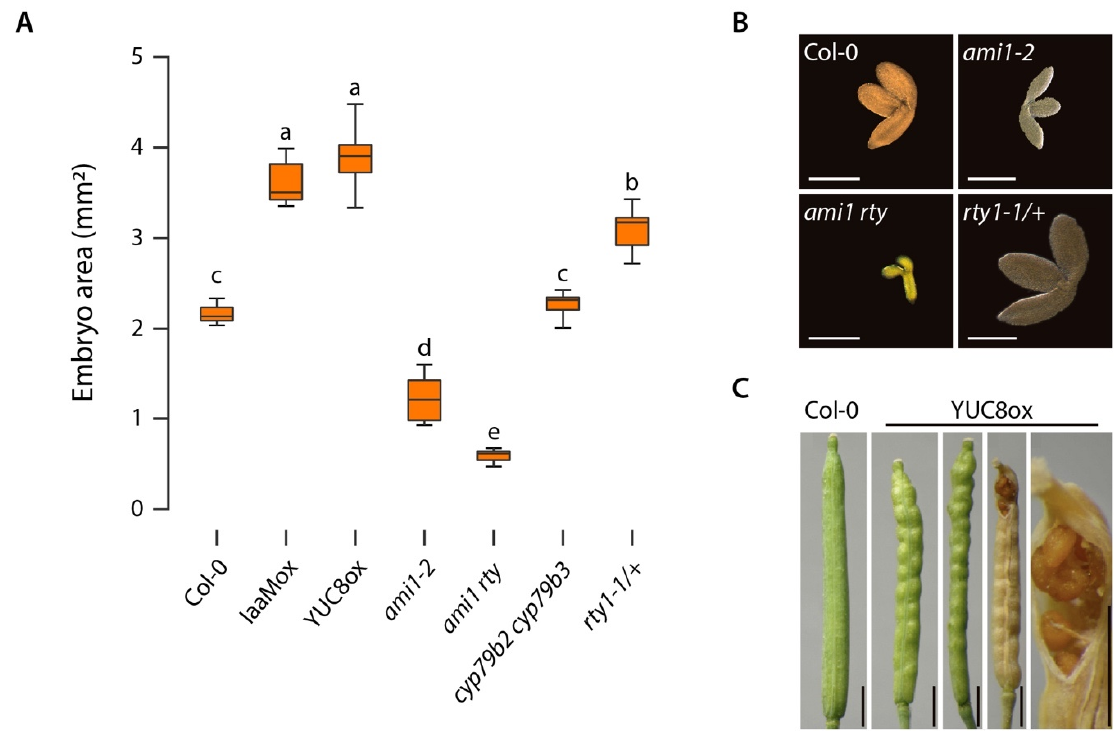
Figure 4. Effect of auxin on embryo and seed size in auxin mutants. ( A ) The box plots show the comparison of the embryo size of different auxin-related mutants. They display the median, quartiles, and extremes of the compared embryo sizes, n = 12. To assess significant differences in embryo size an analysis of variance ( ANOVA ) of the scores followed by Tukey’s post-hoc test was performed. The different letters indicate significant differences, p ≤ 0.001. ( B ) Representative photographs of an ami1-2 , rty1-1/+ , and ami1 rty embryo in comparison to wt (Col-0). The photographs have the same scale, scale bars = 1 mm. ( C ) Representative pictures of siliques from Col-0 and YUC8ox plants. Scale bars = 5 mm.